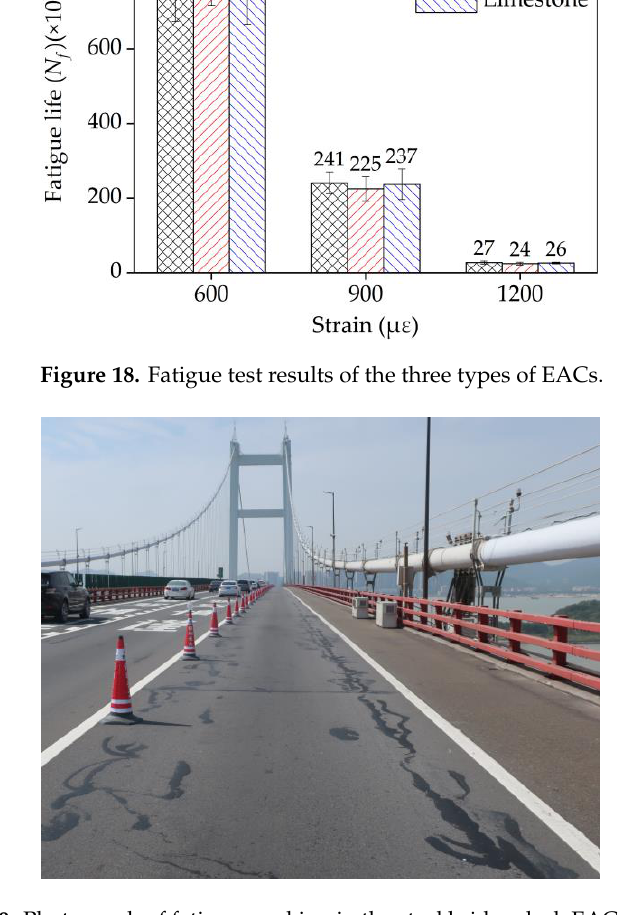
Figure 19. Photograph of fatigue cracking in the steel bridge deck EAC pavement.